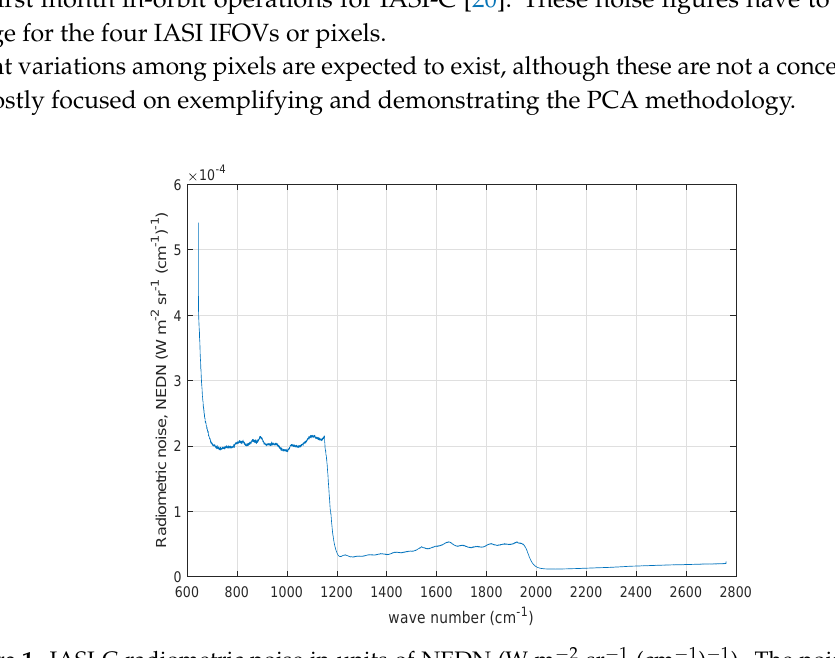
Figure 1. IASI-C radiometric noise in units of NEDN (W-m − 2 sr − 1 (cm − 1 ) − 1 ). The noise has been averaged over the four IASI pixels or IFOVs.